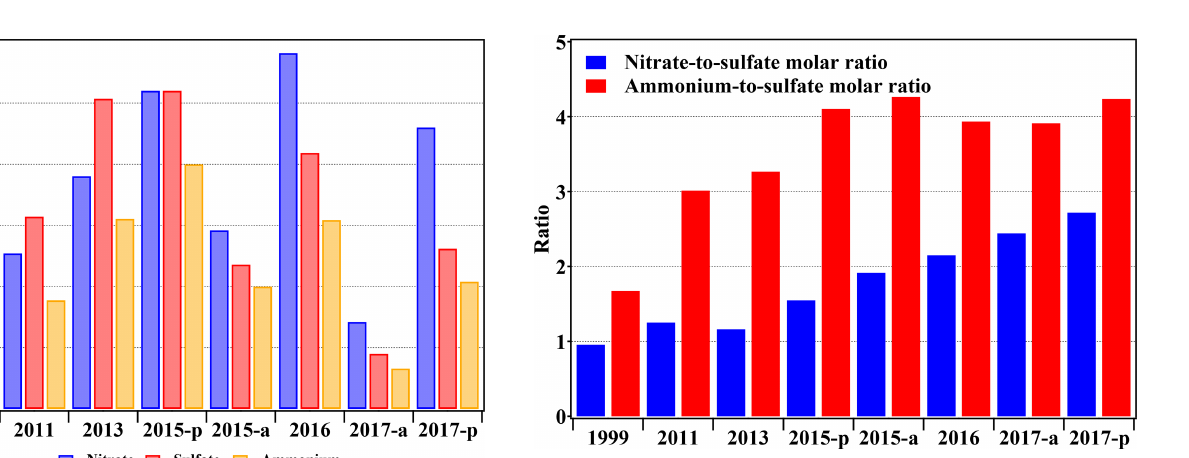
Figure 4. Major inorganic compositions in PM 2 . 5 observed in Bei- jing during winter from representative articles. The results of 2017 denote the average concentration during haze episodes in this study. For details of the reviewed literature, please refer to Table S1 in the Supplement.